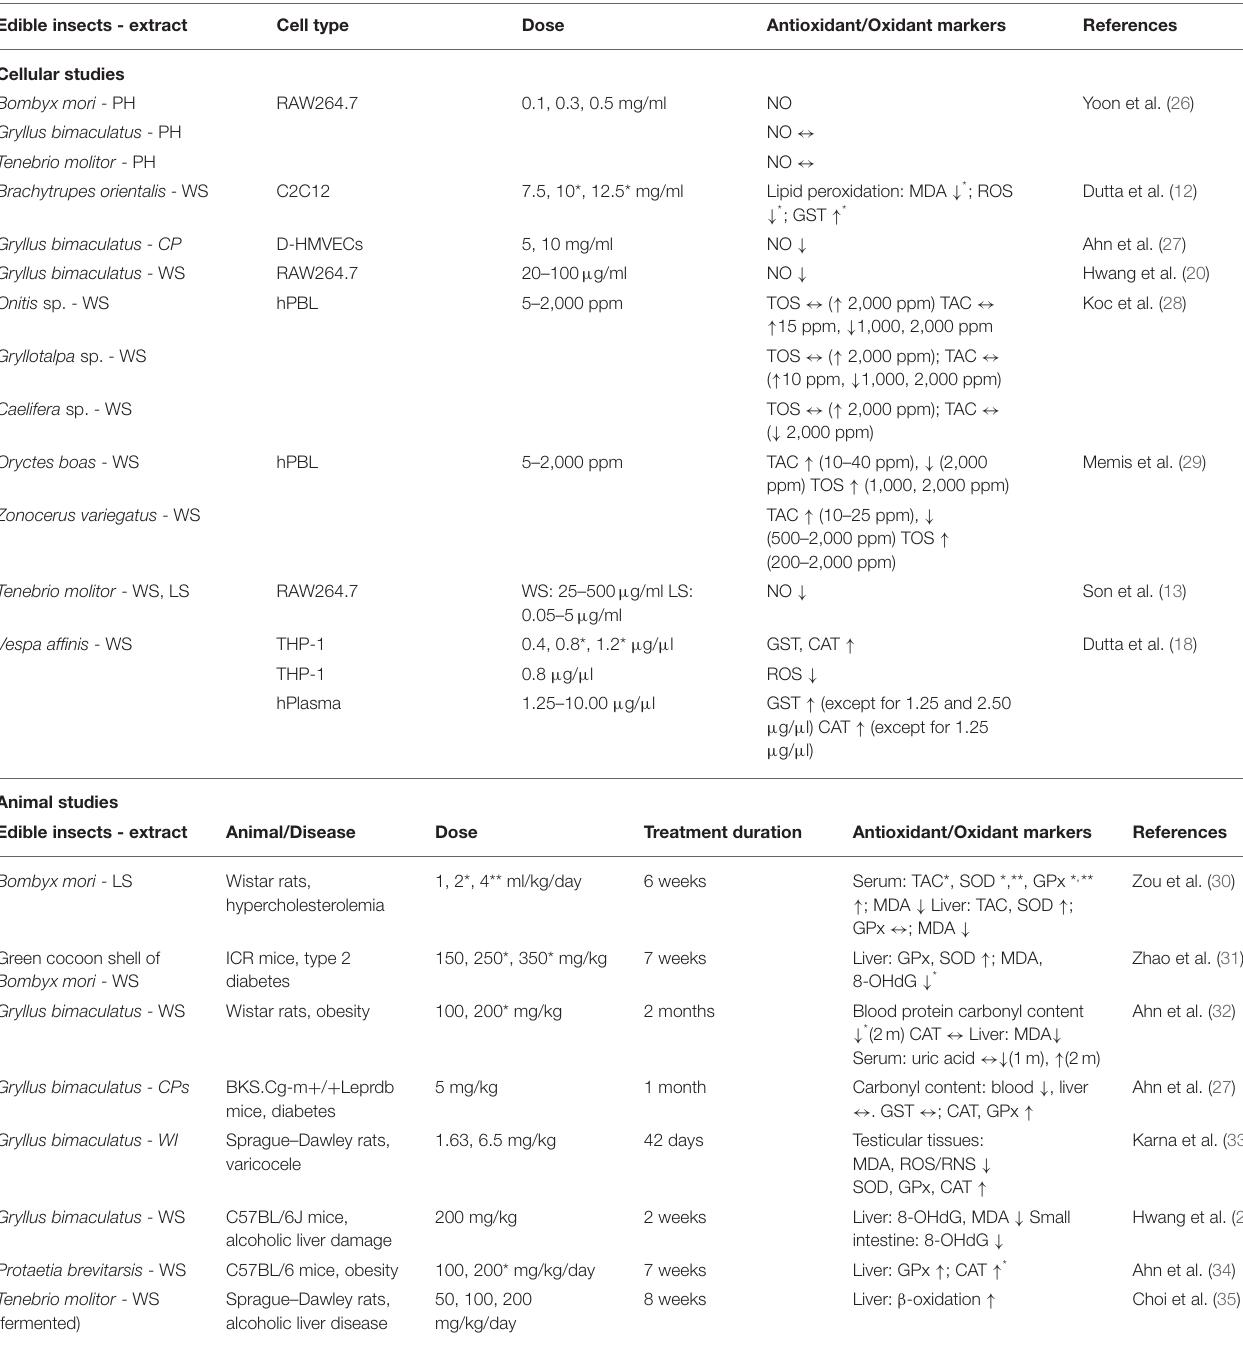
TABLE 2 | Antioxidant activity of edible insects and invertebrates in cellular and animal models. Edible insects -